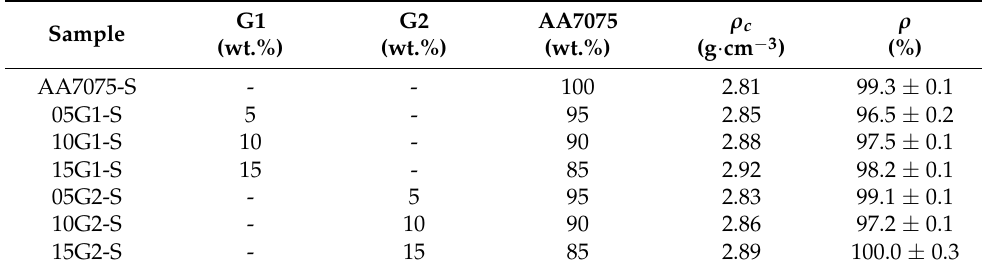
Table 3. Calculated ( ρ c ) and experimental relative density ( ρ ) of the 20 mm sintered samples. Sample